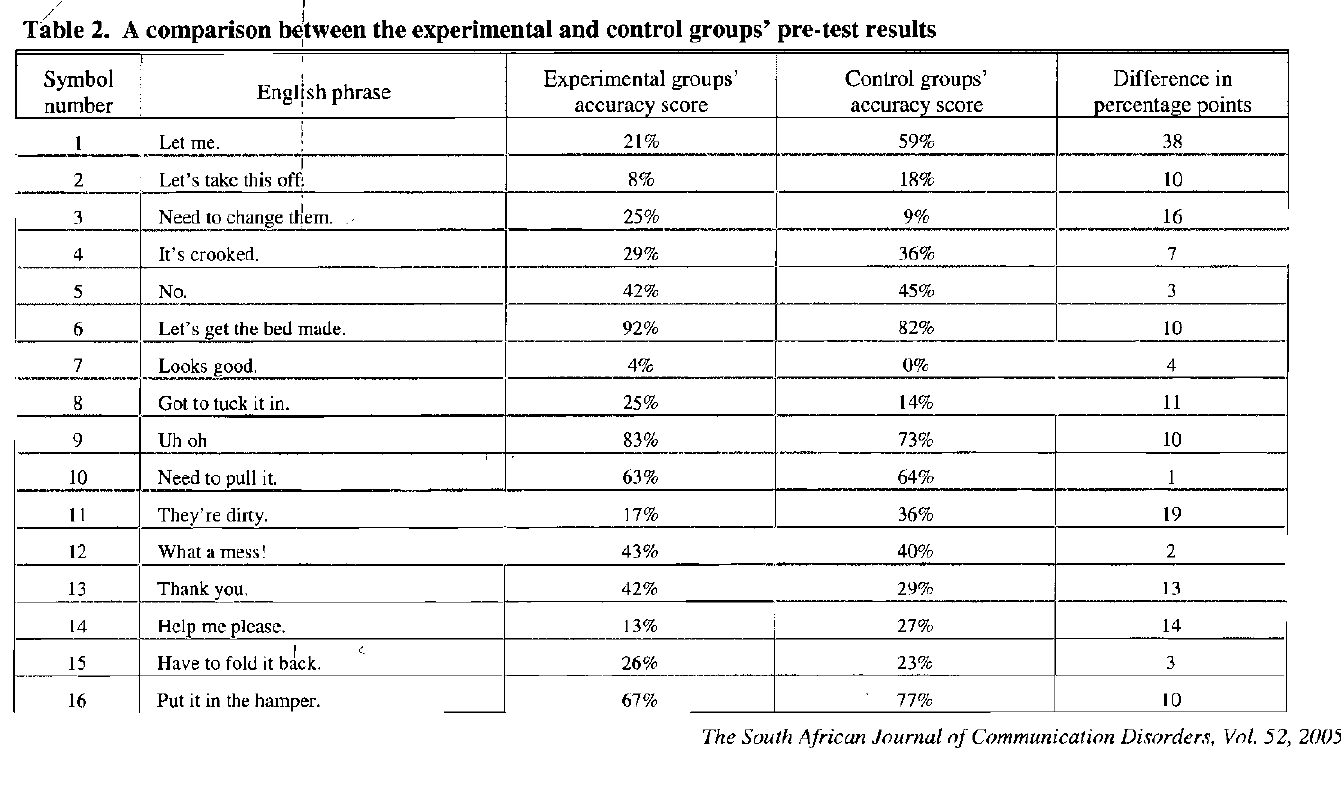
The second sub-aim was to determine the accuracy